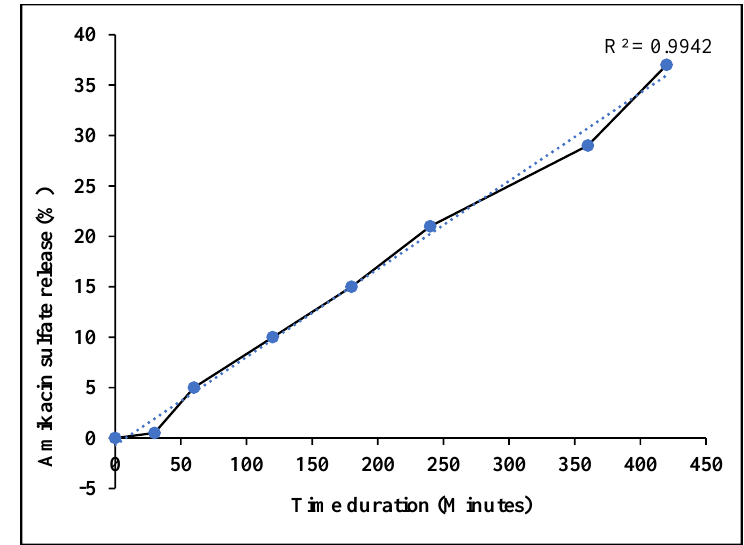
Figure 7. In vitro dissolution profile.